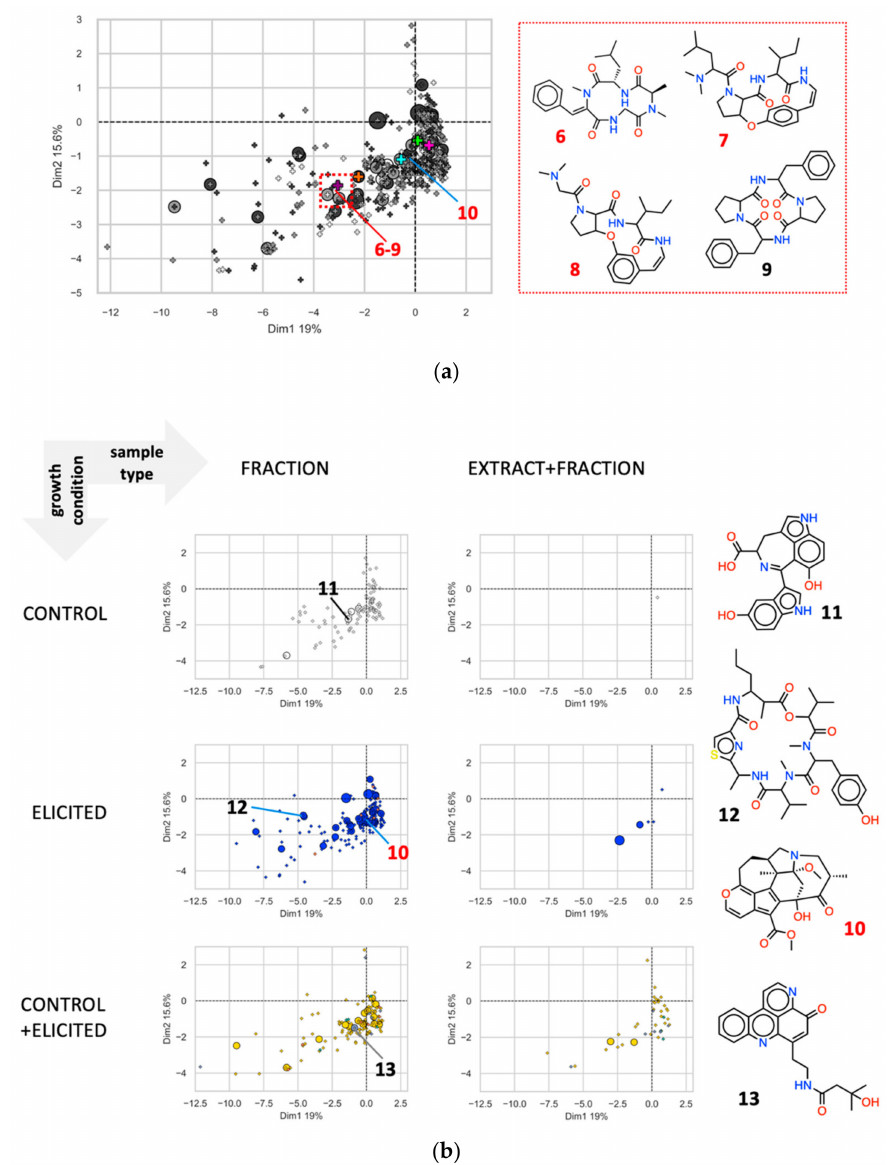
Figure 7. Expansion of the chemical space by inclusion of similar non-identified spectra and dissection of the chemical space by sample type and growth condition highlights the expression modulation of minor nitrogenated metabolites (Q3) and analogues by chemical elicitors. ( a ) A principal component analysis was performed based on molecular descriptors of identified [M + H] + consensus spectra detected in this work. Each identified compound is represented by a cross in the plots and the circles denote the occurrence of non-identified analogous [M + H] + consensus spectra in the collection. Circle size corresponds to the number of non-identified neighbors connected to the identified compound in the SSMN. Compounds 1–5 are highlighted purple, orange, cyan, green and magenta. ( b ) The PCA plot was split based on the cultivation method employed for bacterial cultures (growth condition: control (white), elicited (blue) and both (yellow)), and further by the sample type in which the spectra were found (sample type: chromatographic fraction (minor compounds) or both (major compounds)). Compounds derived from bioactive fractions are highlighted in grey (LAMA915), green (LAMA639) and red (B002_754). Representative compounds from the spectra databases used for metabolite identification, sharing spectra similarity to the EPfB [M + H] + consensus spectra, were selected and are represented; 6: tentoxin; 7: mucronine J; 8: nummularine F; 9: cyclic tetrapeptide (PheProPhePro); 10: daphnicyclidin; 11: hyrtiazepine; 12: ulongamide D; and 13: cystodytin C. Numbers in red indicate natural products reported from organisms other than